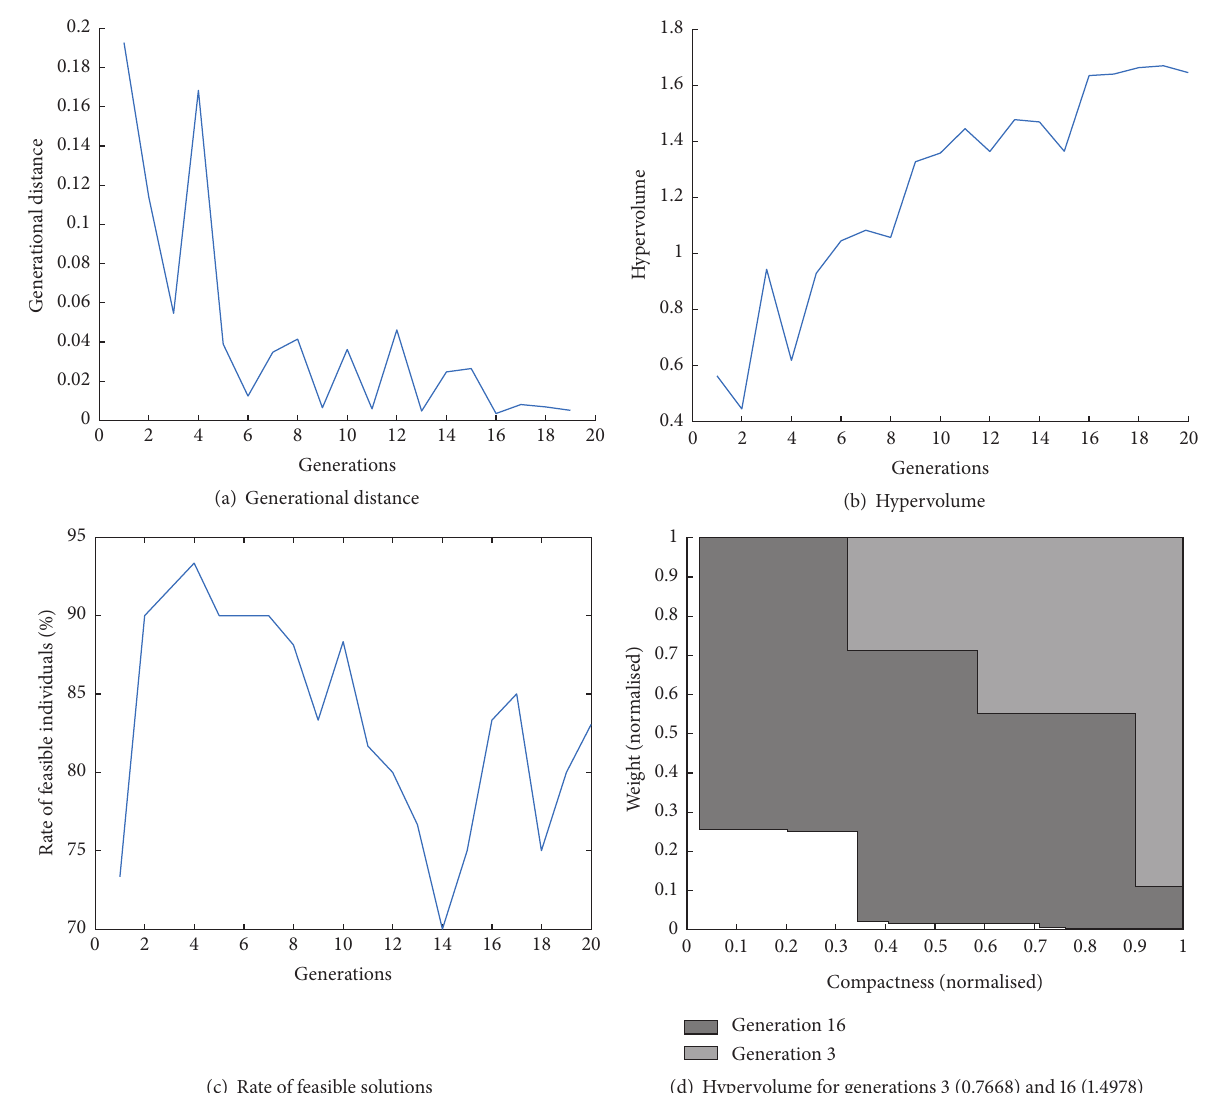
(d) Hypervolume for generations 3 (0.7668) and 16 (1.4978) Figure 9: While the GD is dropping with the generations, the HR is rising and the RF is fluctuating. This means that as the generations progress, the Pareto fronts are coming closer to each other and their extent is becoming bigger while procuring enough solutions that are failing.